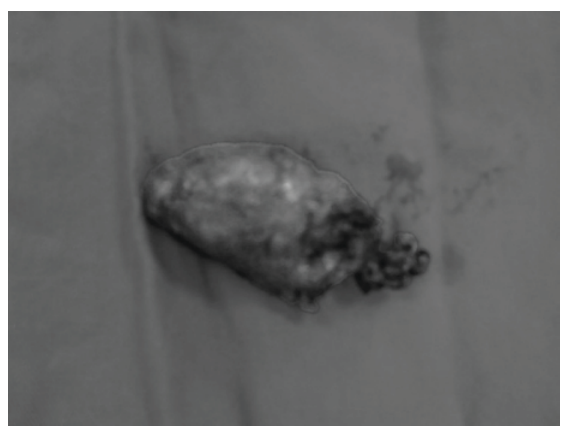
Figure 5. The carotid body tumor after excision.